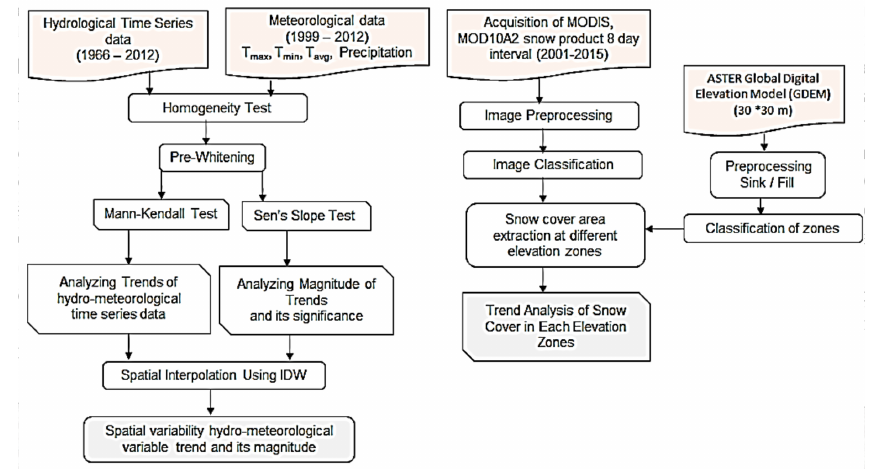
Figure 3. Methodological flow chart of the research